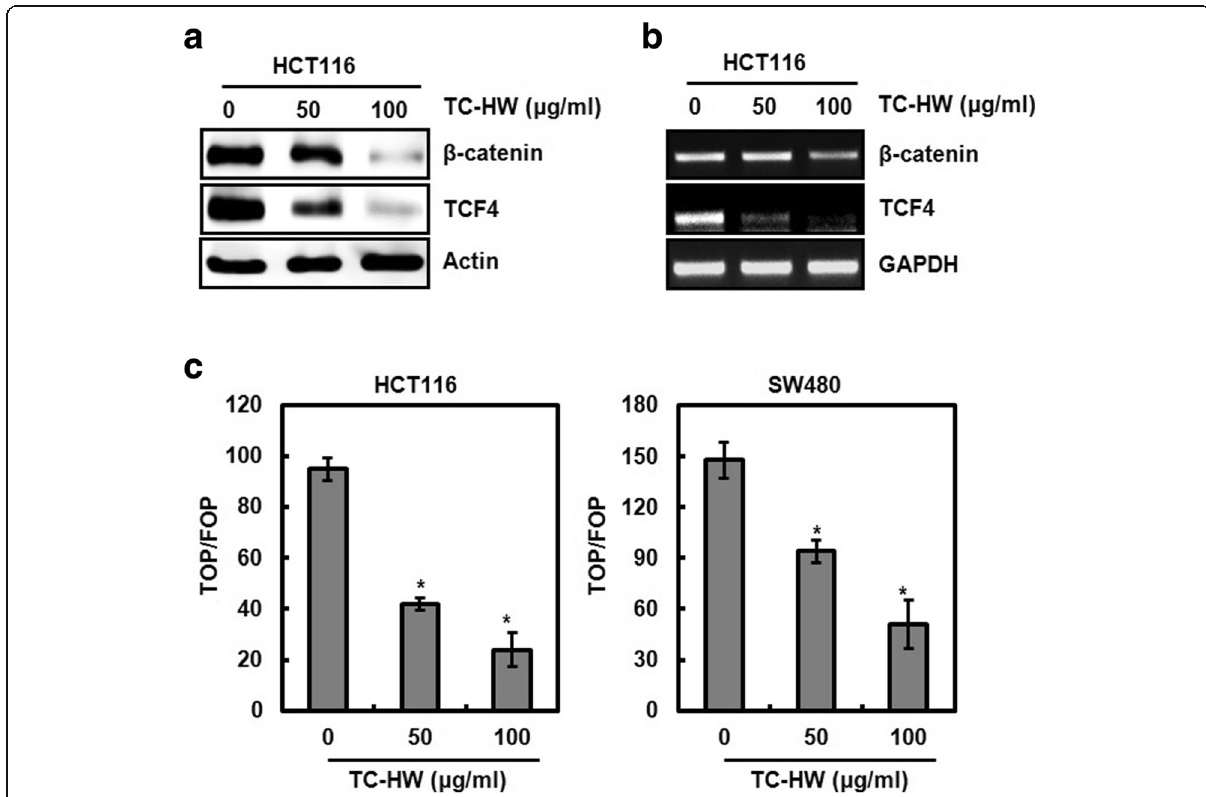
Fig. 3 Inhibition of cyclin D1 transcription by TC-HW through the inhibition of Wnt activation. a and b HCT116 and SW480 cells were treated with TC-HW at the indicated concentrations for 24 h. For Western blot analysis ( a ), cell lysates were subjected to SDS-PAGE and the Western blot was performed using antibodies against β -catenin or TCF4. Actin was used as internal control for Western blot analysis. For RT-PCR analysis of the gene expression of β -catenin and TCF4 ( b ), total RNA was prepared. GAPDH was used as internal control for RP-PCR. c HCT116 and SW480 cells were co-transfected with TOP-FLASH or FOP-FLASH constructs containing wild-type or mutated TCF binding sites and pRL-null. The cells were treated with TC-HW for 24 h. Luciferase activity for TOP-FLASH and FOP-FLASH was measured as a ratio of firefly luciferase signal/renilla luciferase signal using a dual luciferase assay kit. * P < 0.05 compared to cell without